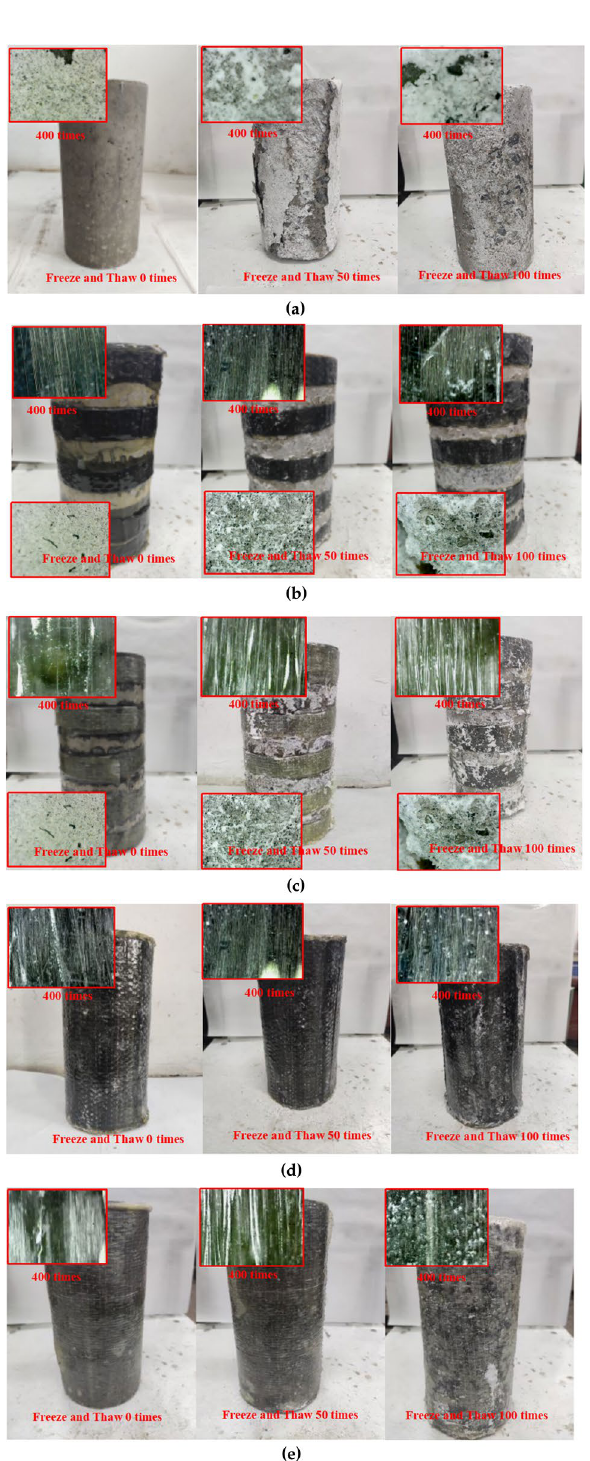
Figure 4. Freeze–thaw erosion appearance of concrete columns: (a) unconfined concrete column; (b) CFRP semi-confined concrete; (c) GFRP semi-confined concrete ; (d) CFRP fully-confined concrete; (e) GFRP semi- confined